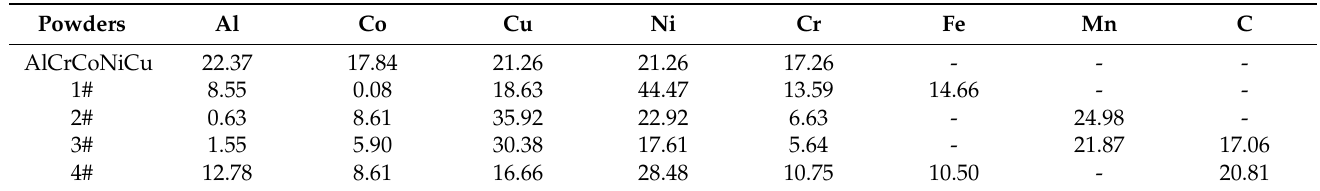
Figure 2. ( a – c ) Surface Micromorphology and EDS of AlCrCoNiCu High Entropy Alloy Spherical Powder. Table 2. The real element content of five kinds of high entropy alloy spherical powder with deter- mined by the SEM-ESD analysis